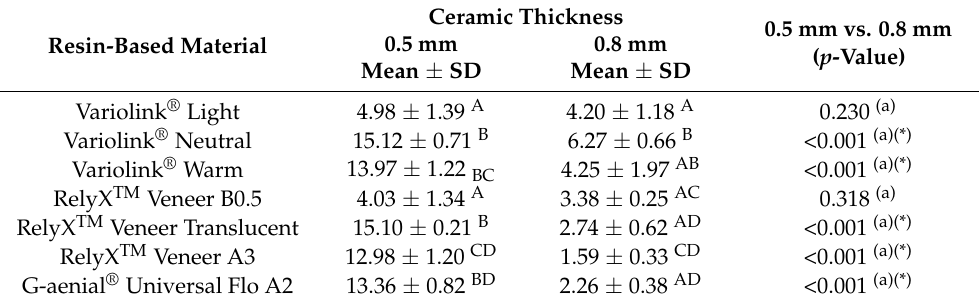
Table 2. Mean ∆ E values and standard deviation (SD) between samples of cemented ceramics and the initial ceramic samples. Different letters in the same column indicate significantly different mean ∆ E